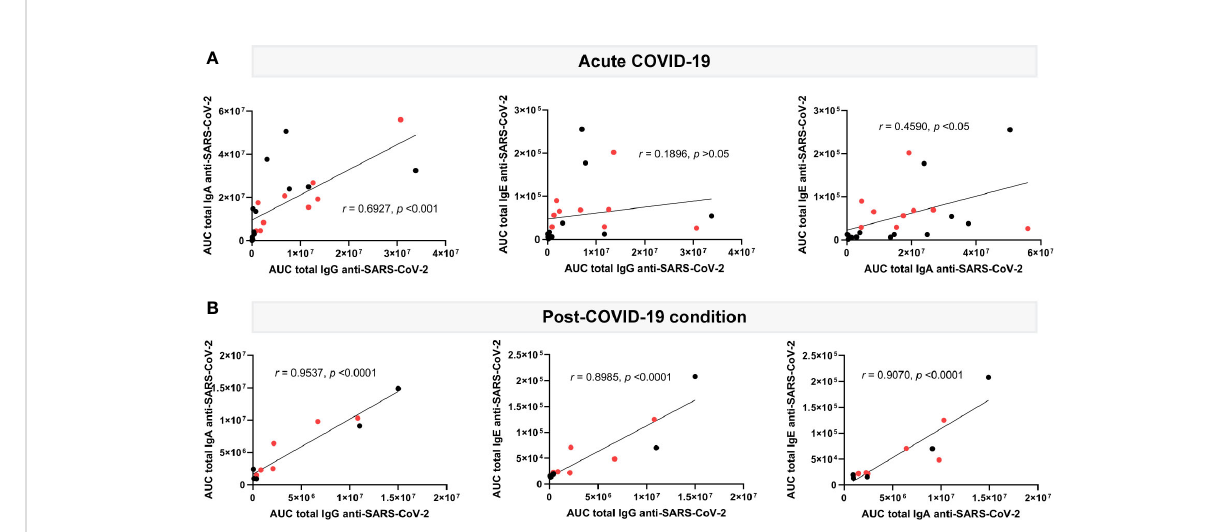
FIGURE 3 Correlation analysis of plasma circulating anti-SARS-CoV-2 immunoglobulin levels in acute (n=22) and post-COVID-19 condition (n=12). Levels of IgG, IgA and IgE against the SARS-CoV-2 nucleocapsid and spike (total) are shown as the mean of the area under the curve (AUC) according to electropherogram and its correlation, analyzed in acute (A) and post (B) COVID-19 samples by Pearson. Samples positive for HERV-W ENV protein antigenemia are labeled in